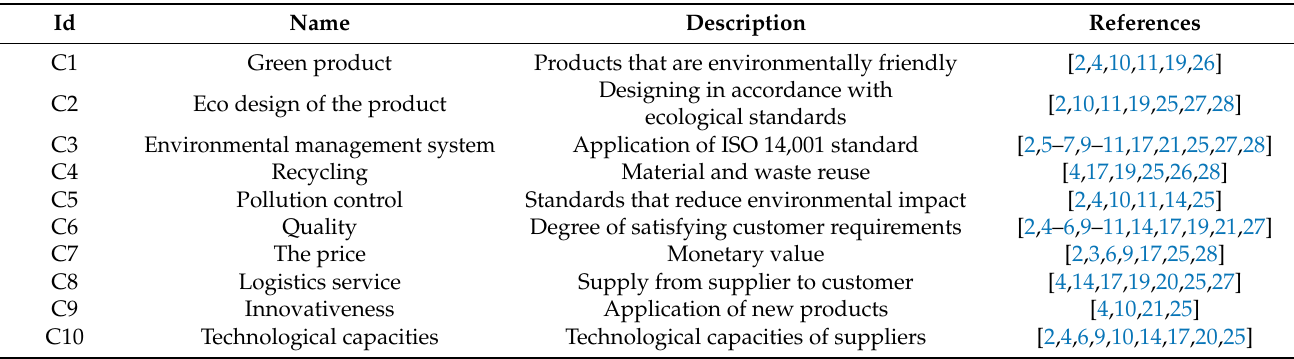
Table 1. Criteria for